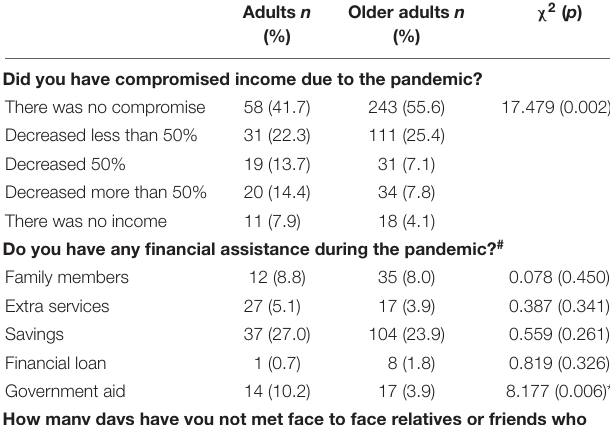
TABLE 2 | Perception of financial conditions and social distancing-related aspects of adults ( n = 139) and older adults ( n = 437). χ 2 ( p ) Adults n Older adults n (%) (%) Did you have compromised income due to the